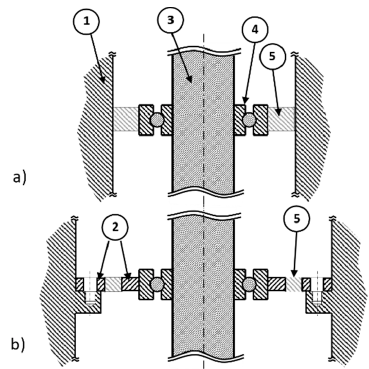
Figure 1. Layout of the suspension. ( a ) Viscoelastic element (square-ring) press-fitted directly between the stator and the ball bearing. ( b ) Viscoelastic element molded between two annular elements. The internal element is press-fitted on the rotor, while the external one is screwed on the stator. (1) Stator of the machine. (2) Damper metallic supports. (3) Shaft. (4) Ball bearing. (5) Viscoelastic section.